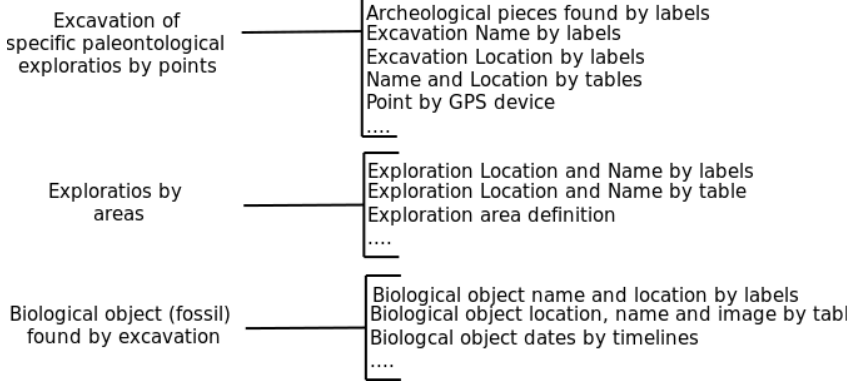
Figure 8. Services defining the way data must be showed to the user.